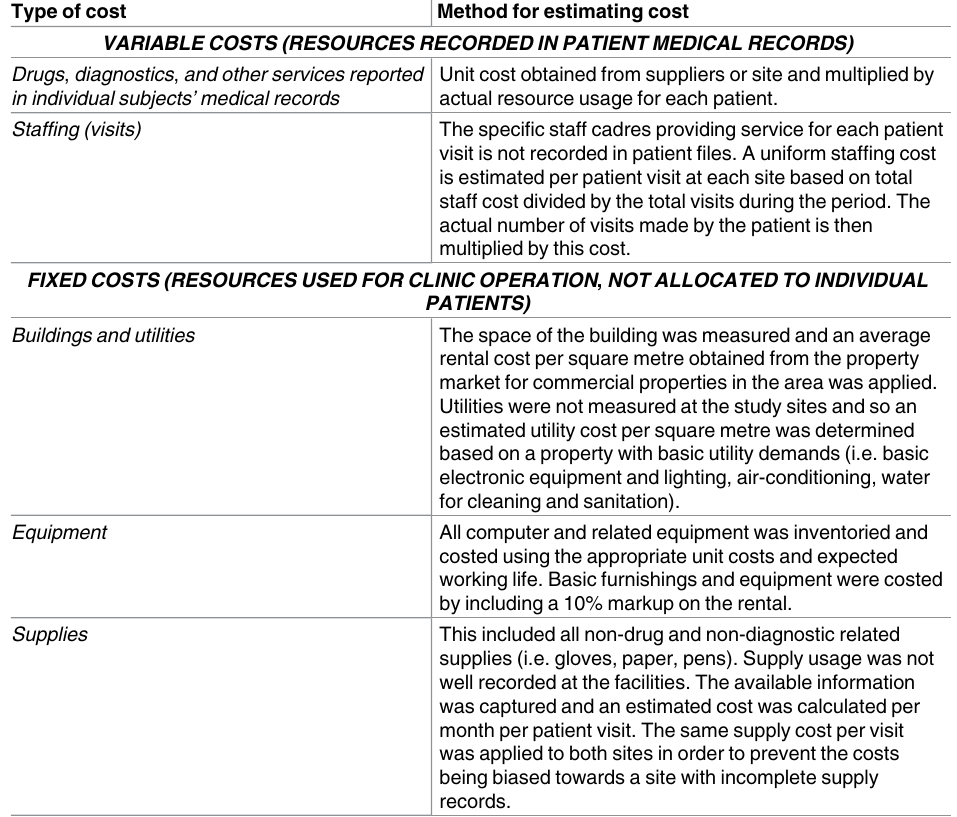
Table 1. Methods for estimating